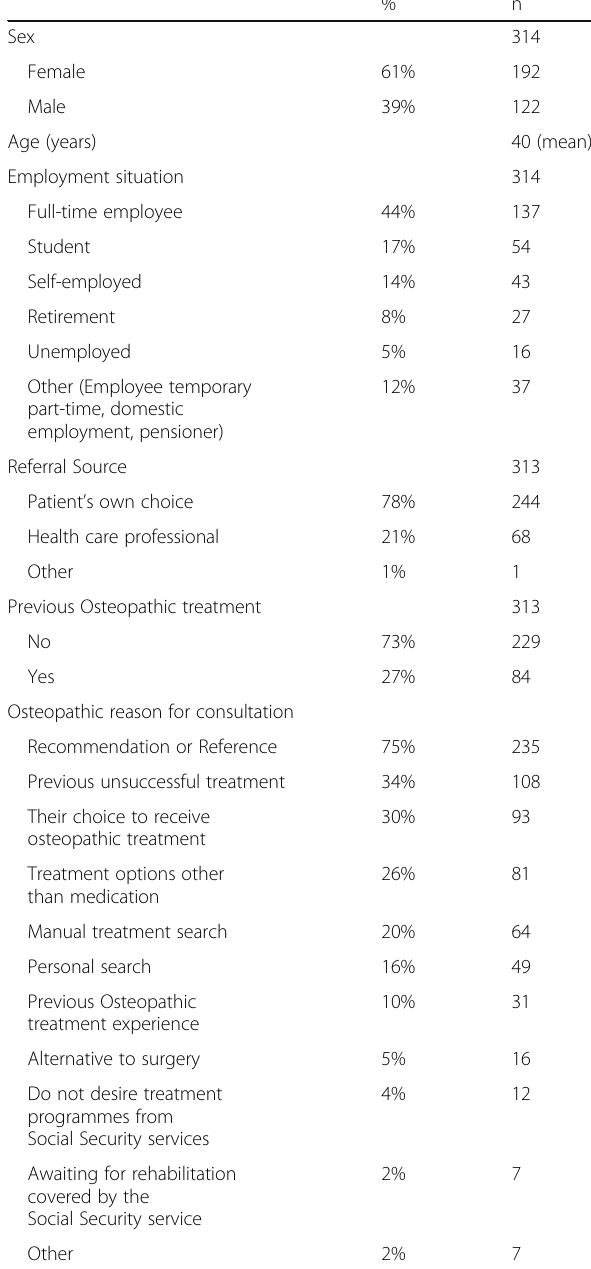
Table 1 Patients socio-demographic